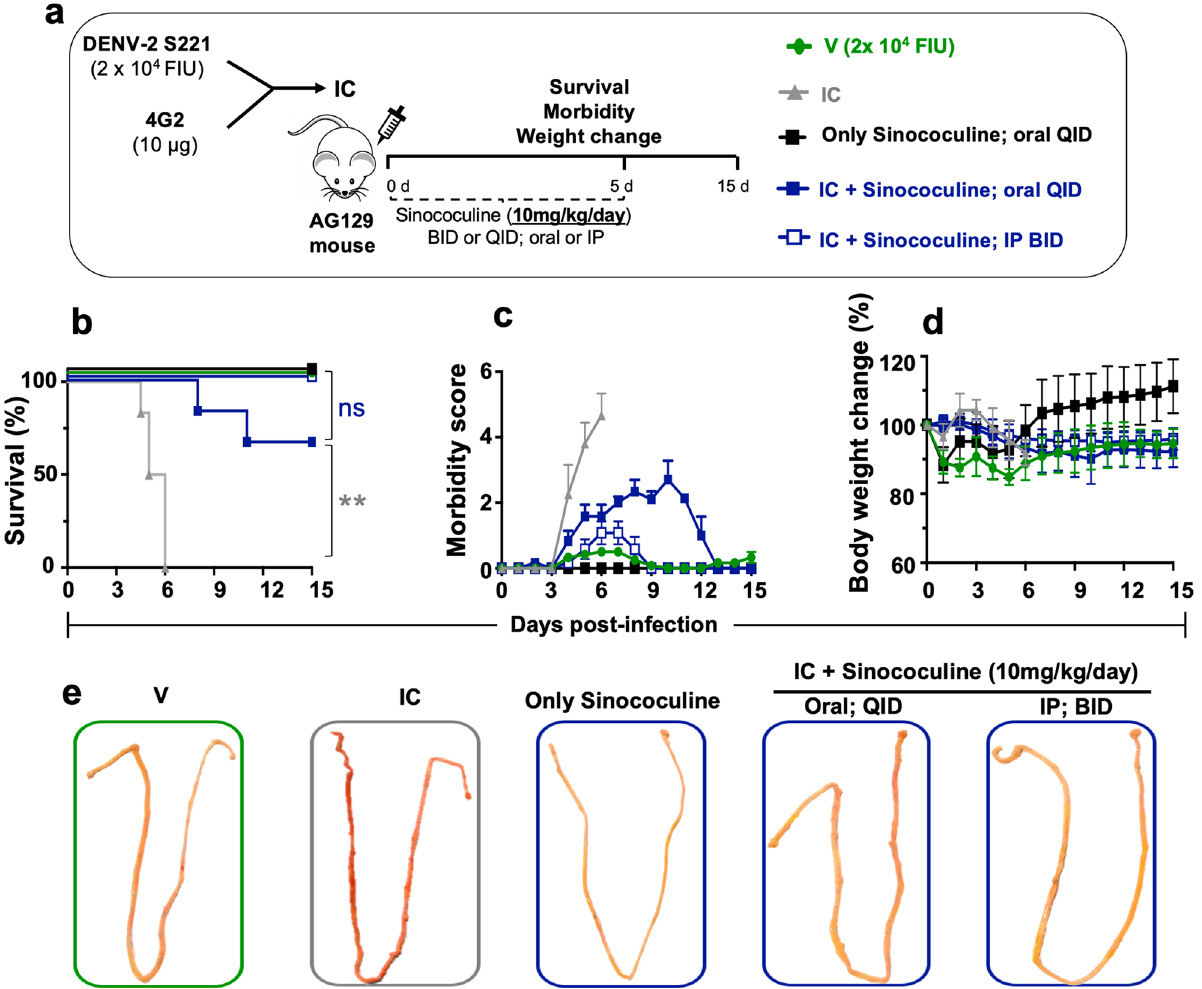
Figure 2. Intraperitoneal injection of Sinococuline is more effective than its oral feeding in protecting the severely DENV infected AG129 mouse model. The in vitro made IC of mouse-adapted DENV-2 S221 strain and 4G2 mAb was inoculated in AG129 mice to establish the severe DENV infection, as reported previously 29 and Sinococuline was administered through the indicated route for evaluation of its efficacy as shown in pictorial diagram ( a ). The IC inoculated AG129 mice (n = 9) were either fed orally (four-times a day; QID; blue coloured curve with filled blue square) or intraperitoneally injected (two-times a day; BID, blue curve with empty blue square) with 10 mg/kg/day Sinococuline (made in sterile 1x PBS) for 5 days. All the mice were scored for their survival ( b ), morbidity ( c ), and body weight change ( d ) for 15 days post-infection. The only Sinococuline group was not infected with IC but fed orally with 10 mg/kg/day (QID; black curve with filled black square), considered as uninfected group. However, V: virus control mice group (green curve with filled green circle, infected with sublethal dose of DENV-2 S221, 2.0 × 10 4 FIU/mouse) and IC group (grey curve with filled grey triangle, infected with IC) were not treated with Sinococuline and instead fed with only sterile 1× PBS (vehicle/placebo) orally (QID) for 5 days, and scored their survival, morbidity and body weight change for 15 days, similarly. The survival data (panel ‘ b ’) were analysed by Mantel–Cox test for significant difference in their survival rates, ns not significant, **statistically significant ( p = 0.0010). On day 4 post-infection, a subset of mice from each group (n = 3) was euthanised, perfused with 1× PBS and their small intestinal lumens were flushed again with PBS and vascular leak was visualised qualitatively ( e ). In panel ( e ), small intestine of only one mouse from each group is represented The antibody-mediated enhanced virus replication is the primary cause of severe DENV-infection. To evaluate the Sinococuline efficacy in reducing the serum viremia, the above assayed mice in Fig. 3a, were bled on day-4 for determination of viral load in the sera. The 50 µl/mouse serum was utilised for SYBR Green-based RT-qPCR assay using DENV specific primers, as reported elsewhere 29,35 . Remarkably, the IC infected mice when treated with both 1.0 mg/kg/day (downward blue filled triangle) and 2.0 mg/kg/day (upward blue empty triangle), lowered the serum viremia significantly (Fig. 3b; represented as viral copies/µl of serum) when compared with untreated or mice treated with lowest dose of Sinococuline (0.5 mg/kg/day; BID; upward blue filled triangle) ( p = 0.0013). However, the reduction of serum viremia by 1.0 mg/kg/day Sinococuline treatment was insignificant when compared with mice treated with 2.0 mg/kg/day of Sinococuline. These results indicate that although 1.0 mg/